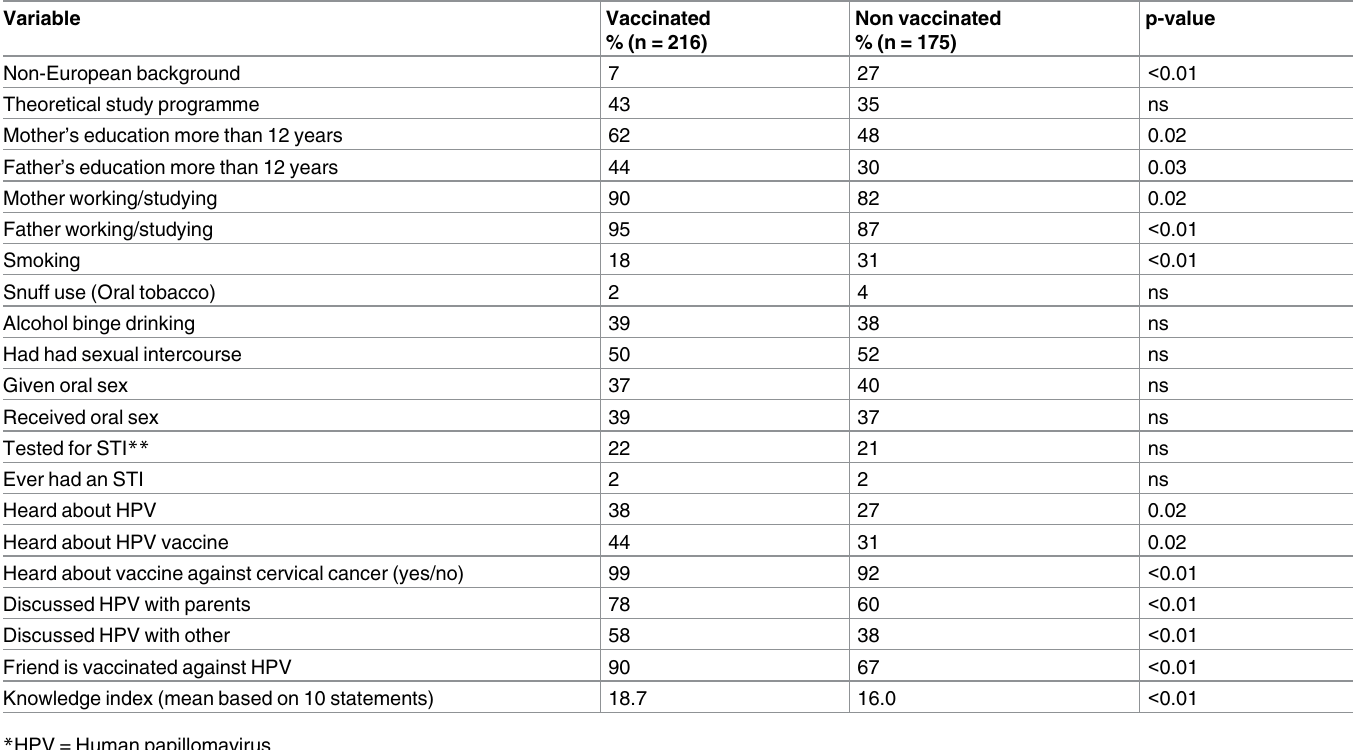
Table 5. Bivariate analysis of differences between HPV * vaccinated and non-vaccinated girls.